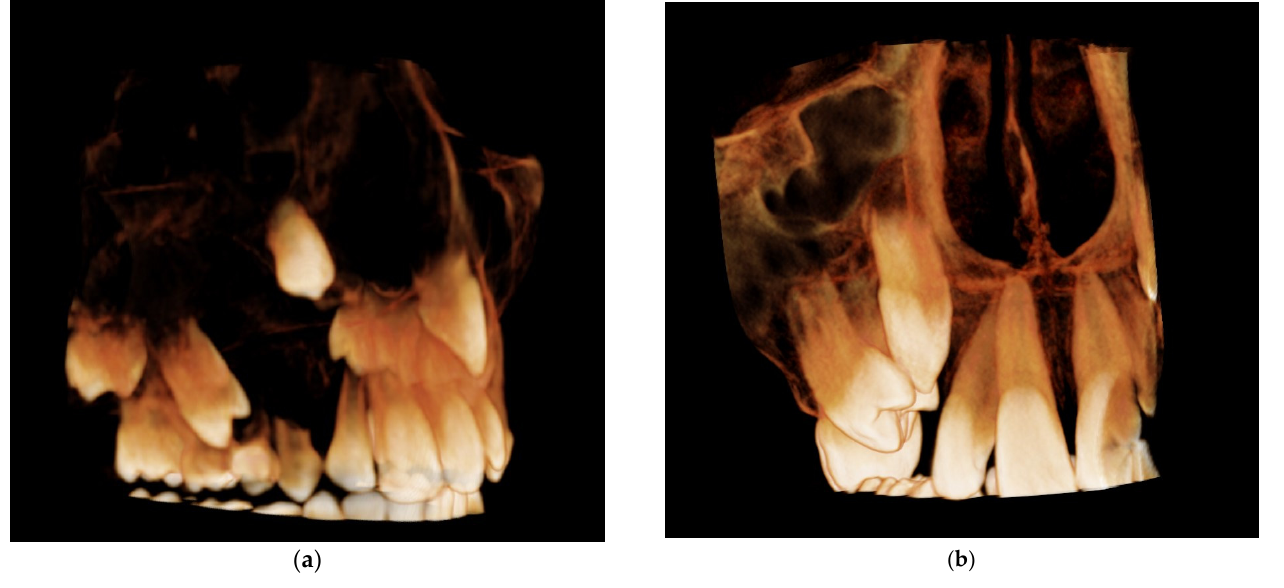
Figure 11. Comparison of three-dimensional CBCT reconstruction before surgery ( a ) and 6 months after surgery ( b ).